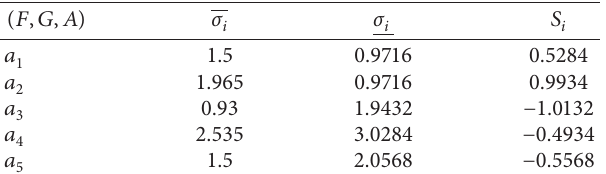
, a , a ,a ,a . 1 2 3 4 5